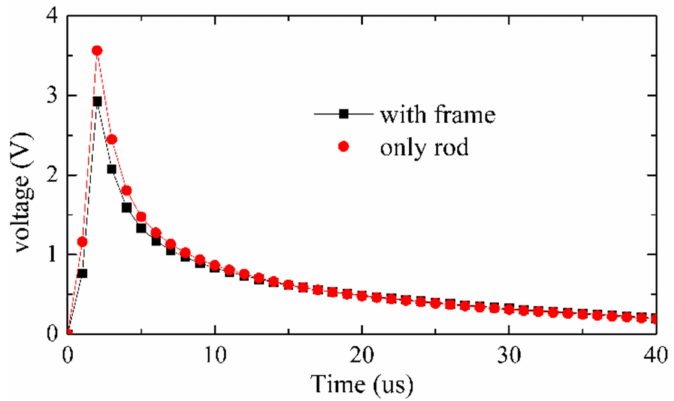
Figure 10. Transient potential at point